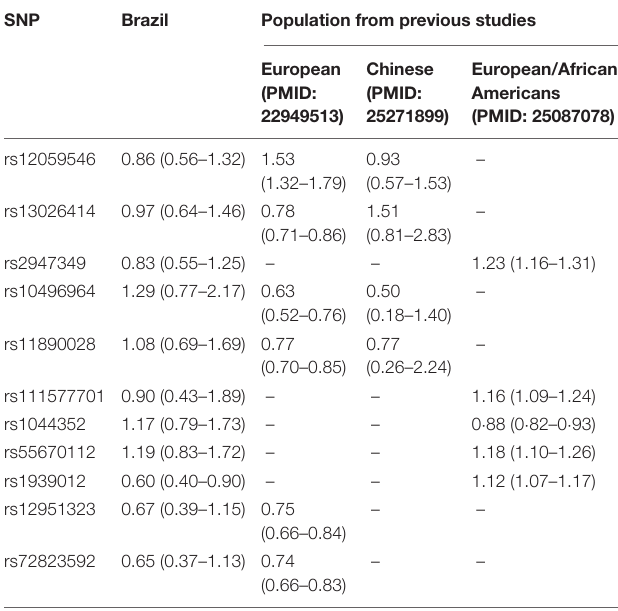
TABLE 3 | Odds ratio comparison among